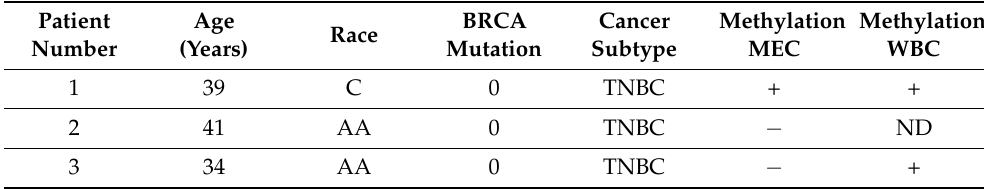
Table 2. Association between breast cancer subtype and KCNK9 -US1 DMR methylation in mammary epithelial cells and white blood